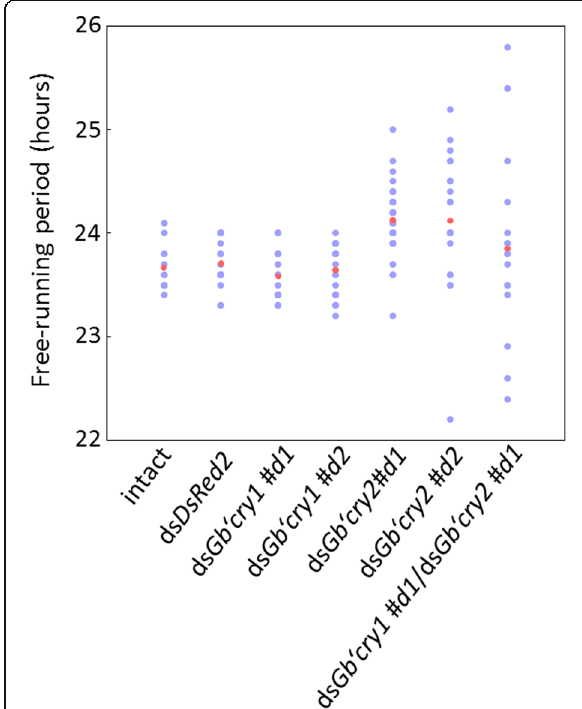
Fig. 4 Distribution of free-running periods of locomotor rhythms of individual crickets Gryllus bimaculatus . Crickets were treated with DsRed2 RNAi , Gb ’ cry1 RNAi (ds Gb ’ cry1#d1 , ds Gb ’ cry1#d2 ), Gb ’ cry2 RNAi (ds Gb ’ cry2#d1 , ds Gb ’ cry2#d2 ), or both Gb ’ cry1 RNAi and Gb ’ cry2 RNAi and their locomotor rhythms were measured under DD at a constant temperature of 25 °C. Blue and red dots indicate individual and average values, respectively. Gb ’ cry1 RNAi crickets showed a similar distribution to that of control, DsRed2 RNAi crickets. The distribution is widely ranging from 23.2 to 25.0 h in Gb ’ cry2 RNAi crickets, and the range is even greater in Gb ’ cry1 / Gb ’ cry2 double RNAi crickets. For further explanations, see the